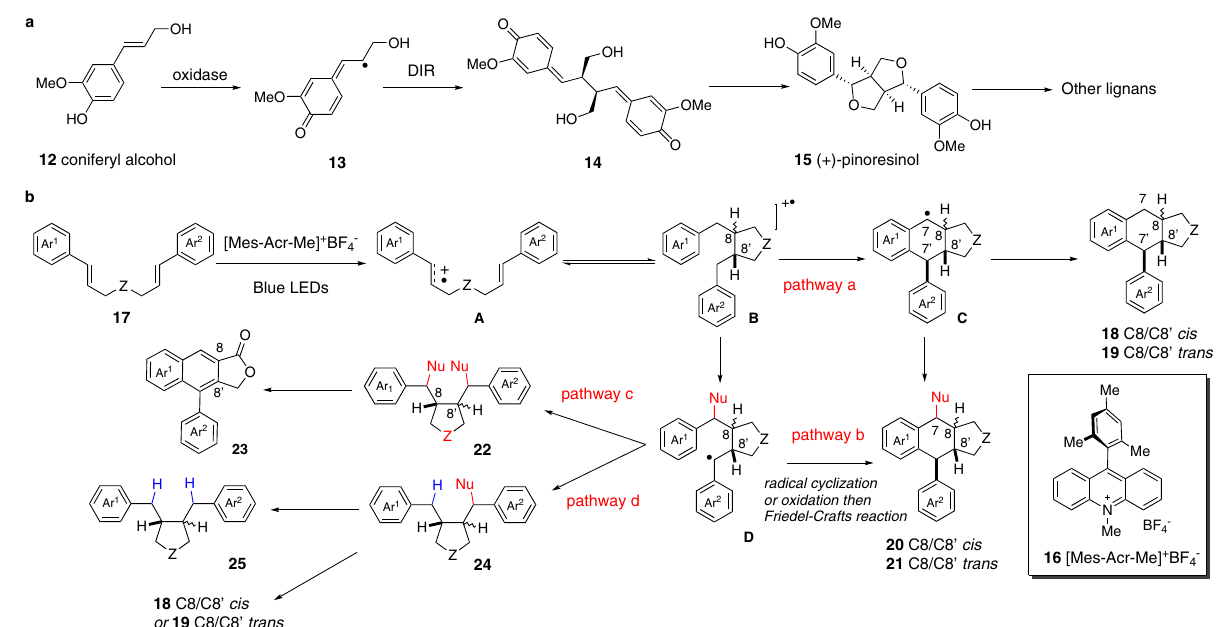
Fig. 2 Lignan synthesis. a Biosynthesis of lignans; b proposed divergent synthesis of